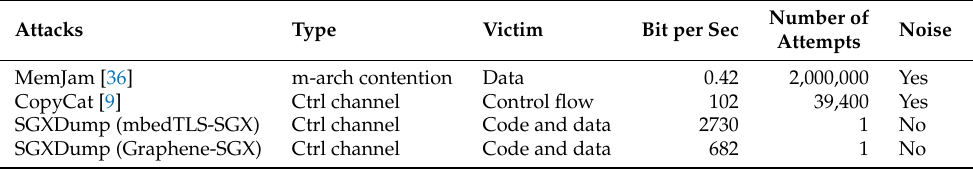
Table 3. Evaluation